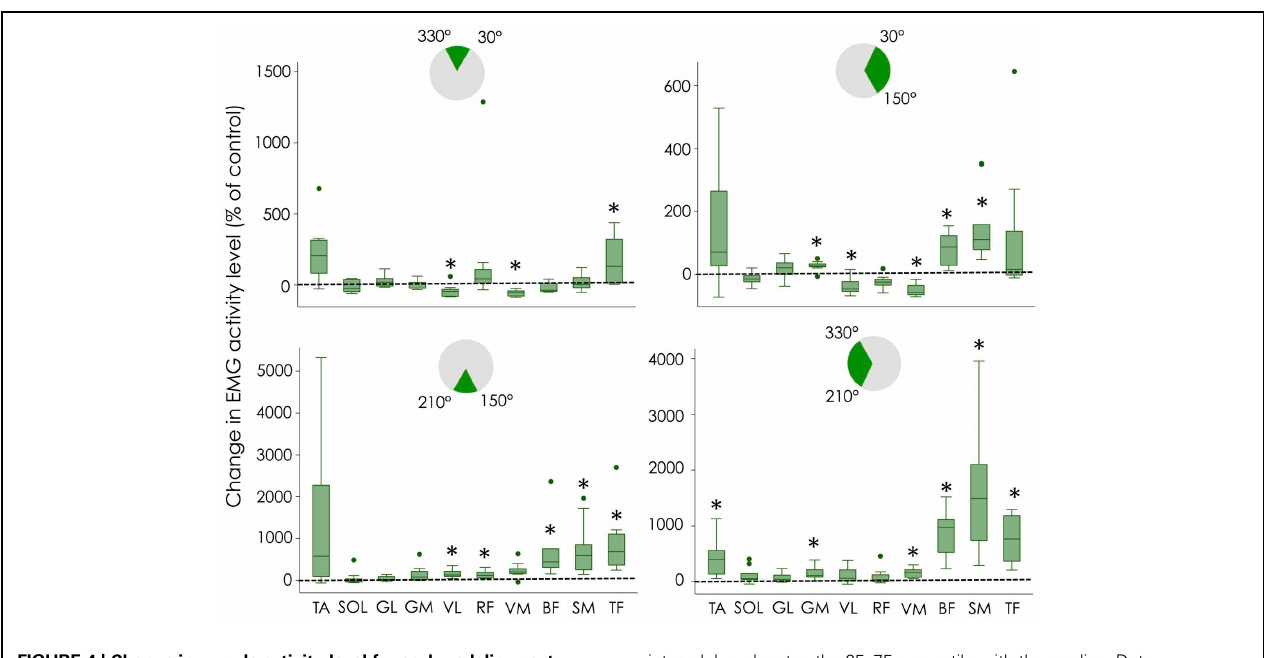
FIGURE 4 | Change in muscle activity level for each pedaling sector. Changes in EMG amplitude normalized to the control condition are shown with box plots for each muscle. Error bars denote the 95% confidence